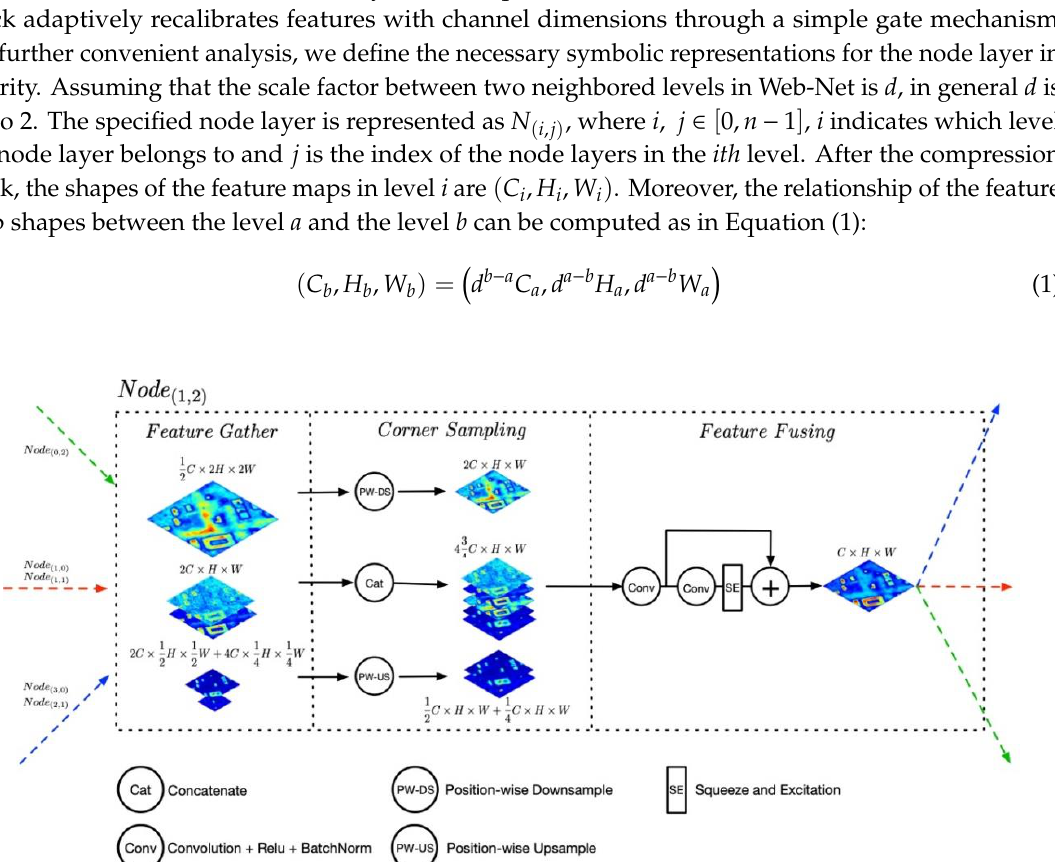
the green dotted lines denote the hierarchical top-bottom skip connections, and the blue dotted lines show the hierarchical bottom-top jump connections. Apparently, each regular triangle with different coloured edges constructs a mini encoder-decoder architecture.